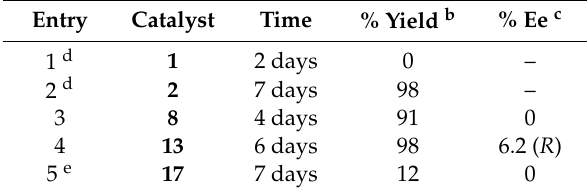
used in all instances. b Isolated yield of aldol 19 , after chromatographic purification. c Determined by